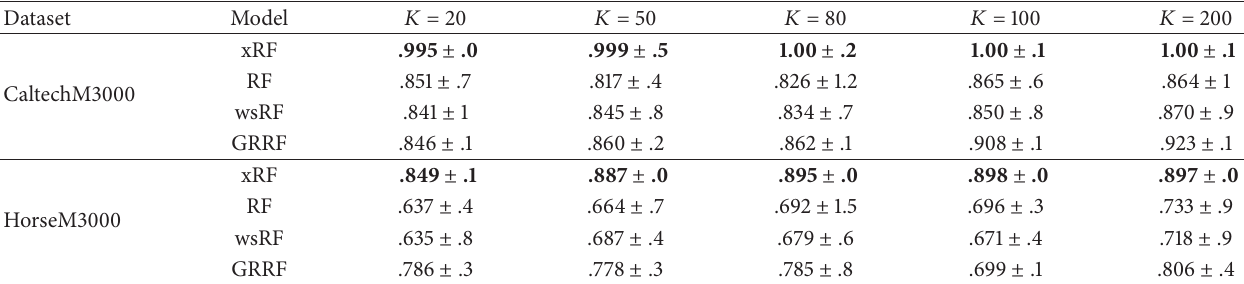
Table 4: AUC results (mean ± std-dev%) of random forest models against the number of trees 𝐾 on the CaltechM3000 and HorseM3000 subdatasets. The bold value in each row indicates the best result.